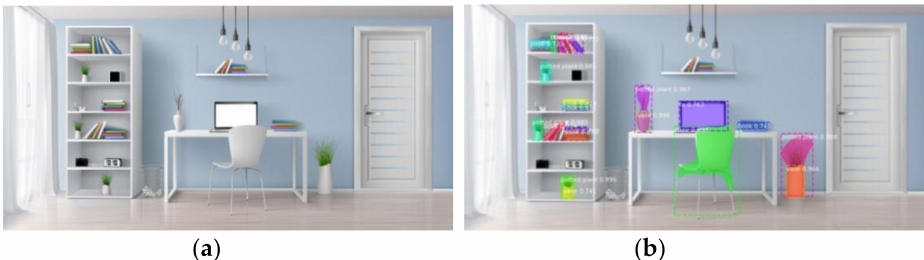
Figure 15. ( a ) Test image; ( b ) output result of the initial code of the Mask R-CNN instance segmenta- tion